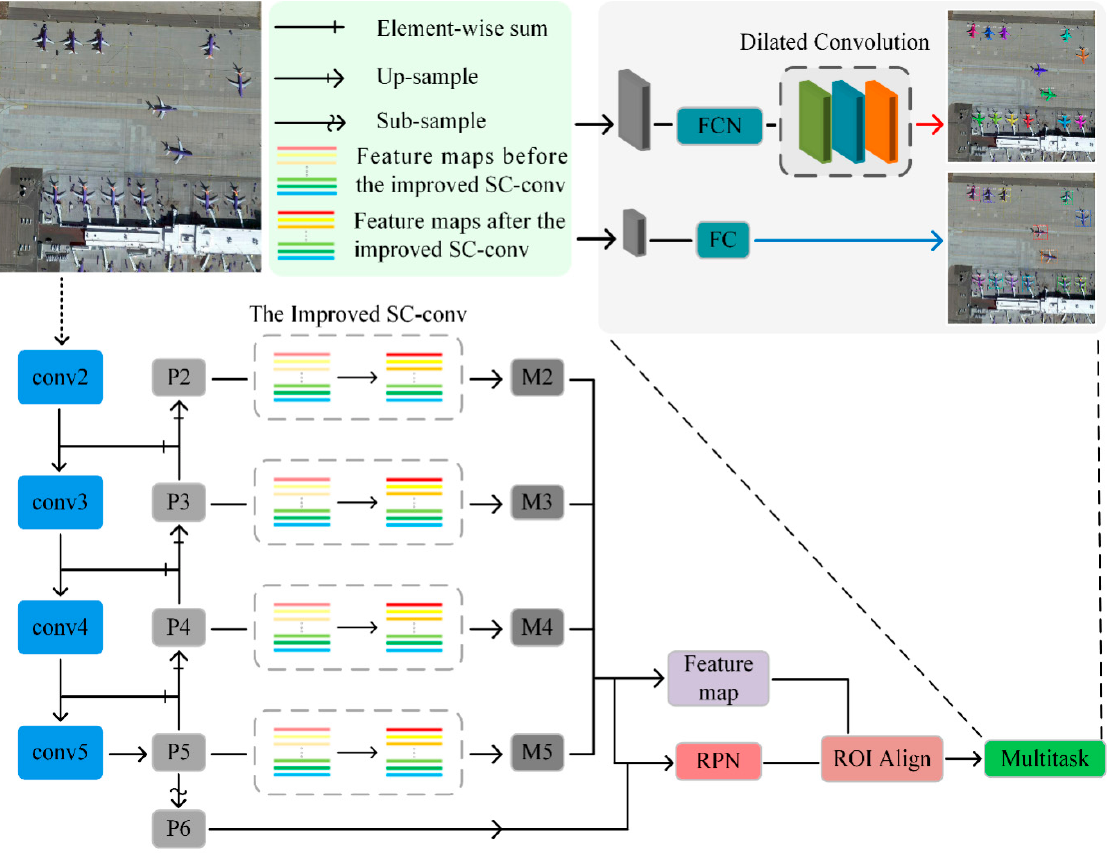
Figure 1. Overall SCMask R-CNN model structure.